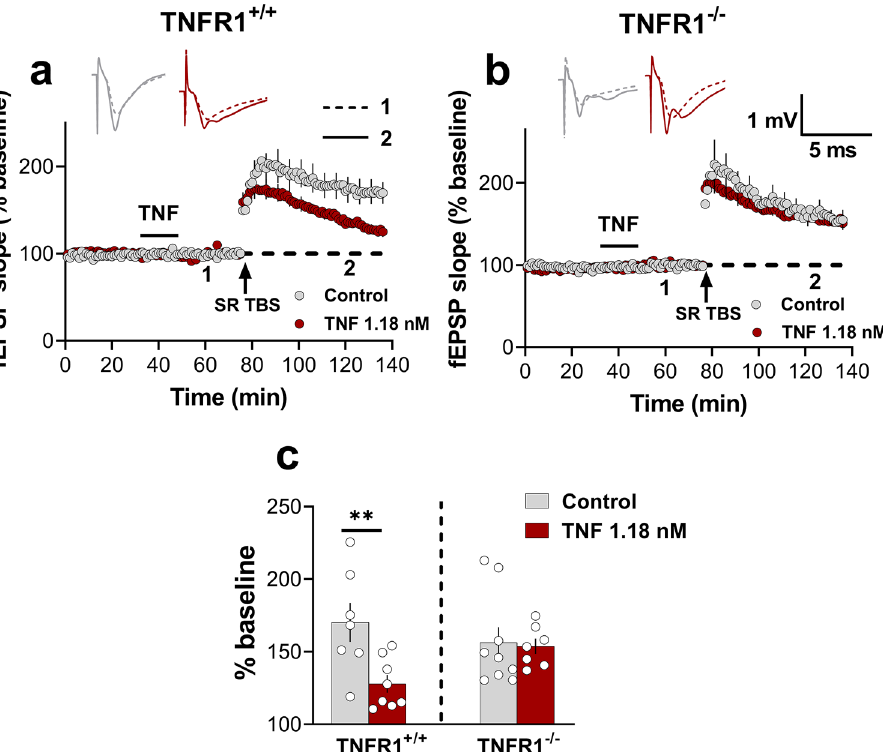
Figure 6. TNF-induced metaplasticity in SR requires TNFR1. ( a ) Bath application of 1.18 nM TNF significantly inhibited SR LTP in TNFR1 +/+ male and female mice (Control = 170.3 ± 14%, n = 7; TNF = 128 ± 9%, n = 8; t (13) = 2.99, p = 0.01). ( b ) TNF had no effect on the LTP in TNFR1 -/- male and female mice (Control = 156.3 ± 10%, n = 9; TNF = 153.8 ± 13%, n = 7; t (14) = 0.19, p = 0.84). ( c ) Bar graph summarising the TNF-mediated priming effect in TNFR1 +/+ mice but not in TNFR1 -/- mice. ** , p <